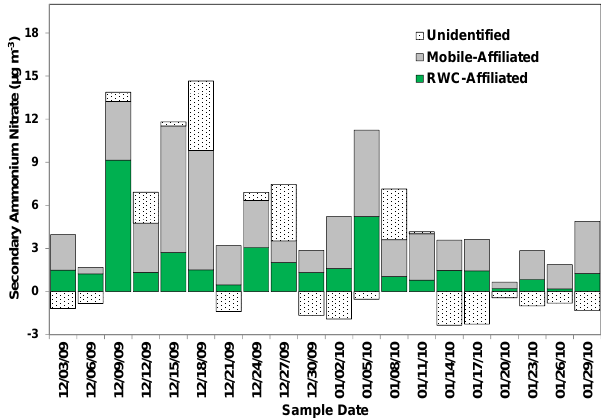
Fig. 10. Source apportionment of secondary ammonium nitrate by robust multiple linear